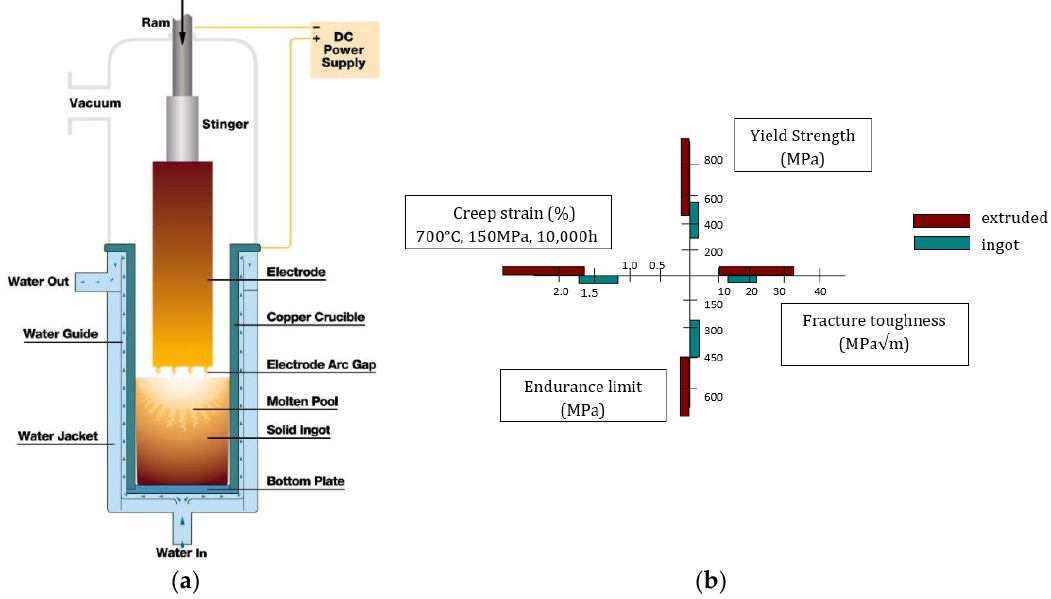
Figure 2. ( a ) Vacuum arc remelting (VAR) furnace (adapted from ATI Allvac©); ( b ) properties of extruded and ingot TiAl.